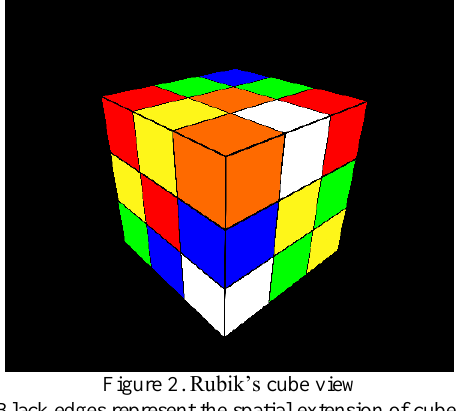
Figure 2. Rubik’s cube view Black edges represent the spatial extension of cubes The Rubik’s cube is located at the origin of the three axis (X, Y and Z) and is positioned symmetrically according to these axis (see figure 3). The camera is positioned on a half-sphere centred at the origin of the axis and moves with 15 degrees increments. This number is fixed arbitrary due to computation requirements but can easily change upon the user’s needs. The more the steps, higher the calculation time. Moreover, a small location difference between two camera positions is not always relevant with respect to the maximisation of objects representation. A half-sphere is considered in order to only obtain views taken from the top. The radius of the sphere has been determined to see the whole Rubik’s cube whether the camera